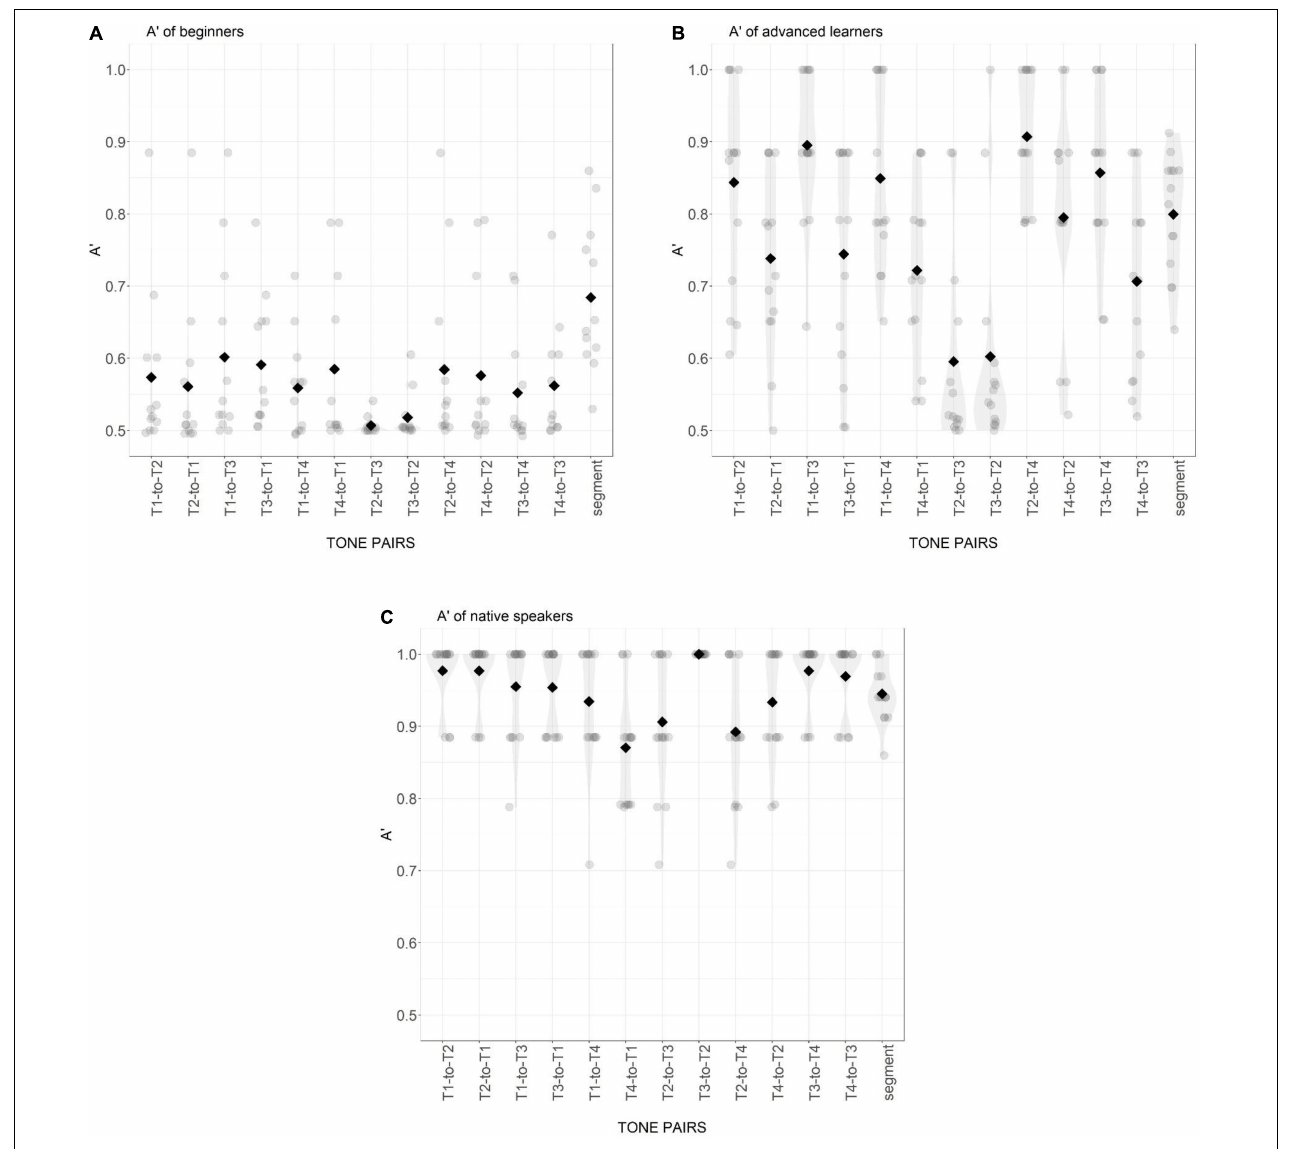
FIGURE 2 | Distribution of A (cid:48) score of beginning learners (A) , advanced learners (B) , and native Mandarin speakers (C) for 12 tone pairs and the segmental condition. Gray points are individual participant means. Black diamonds are condition